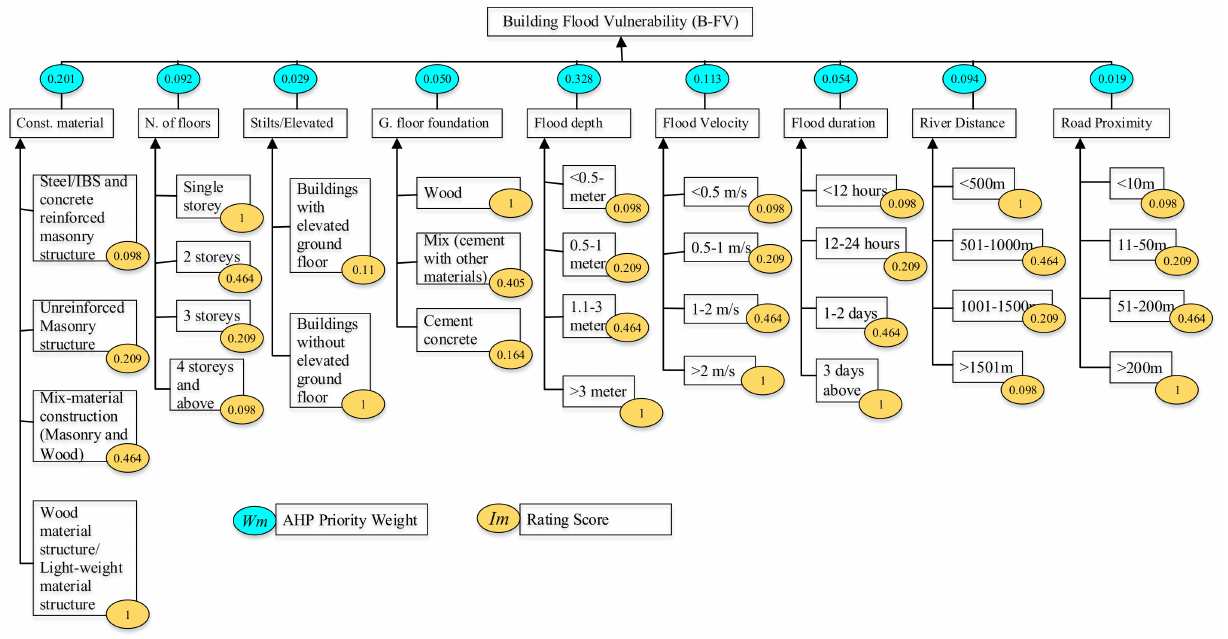
Figure 8. Aggregation model through Weighted Linear